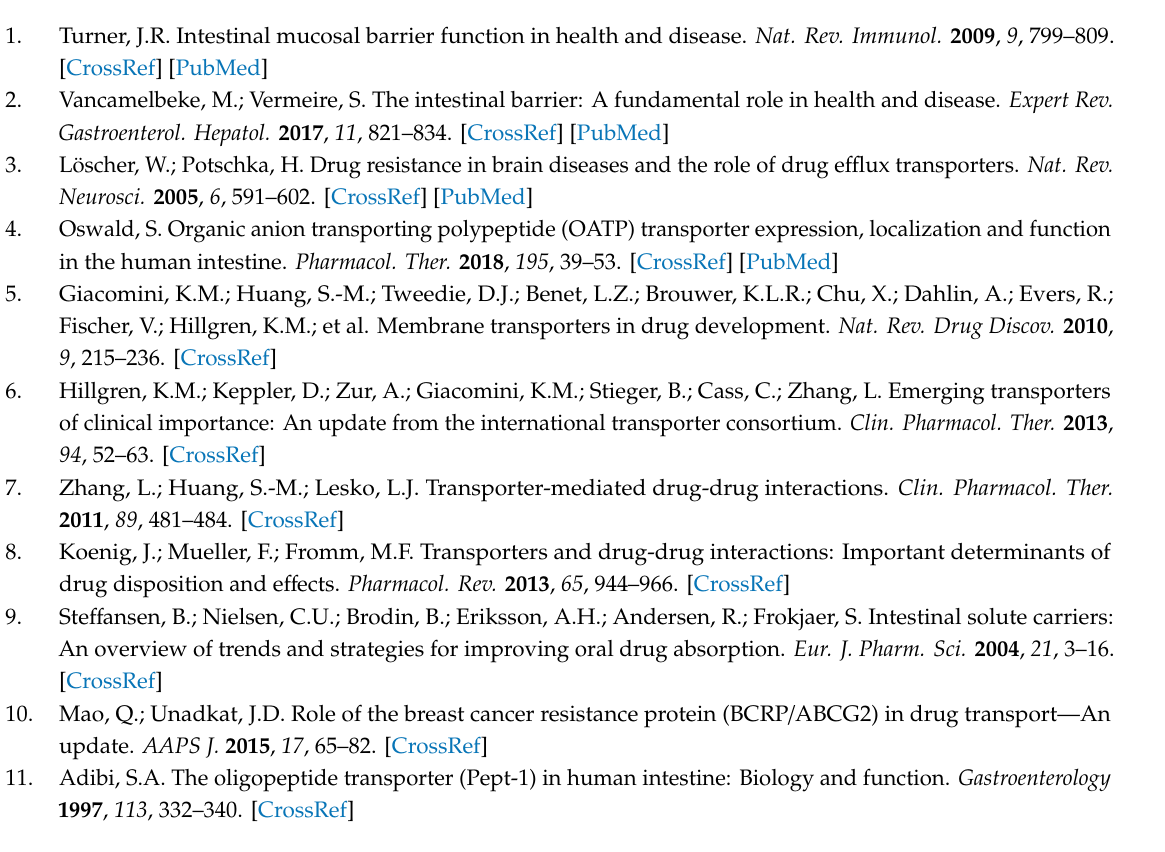
Table S1: UHPLC–MS / MS methods, Table S2: Precision and accuracy of the analytical